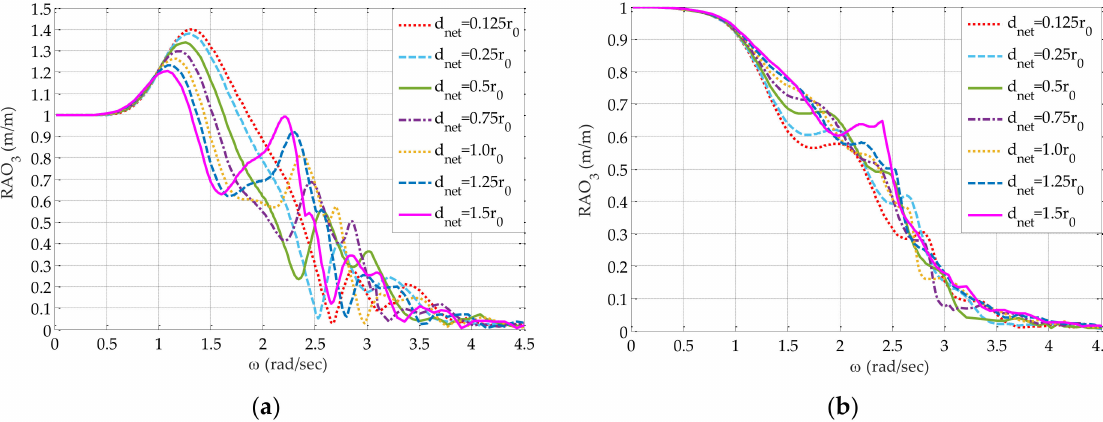
Figure 7. Effect of d net on the heave response of the oblate spheroidal WECs placed around the monopile for β = 0 o : ( a ) WEC1 and WEC4; ( b ) WEC2 and